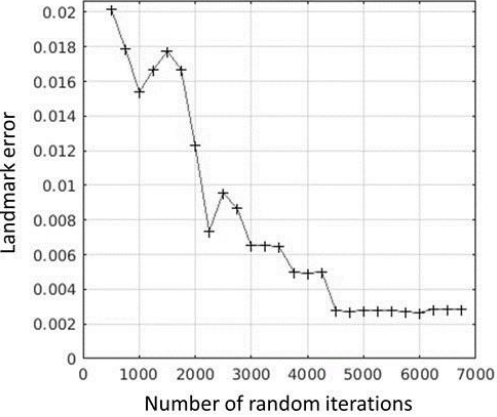
Figure 6. Landmark error over the number of random iterations for the initial transformation.